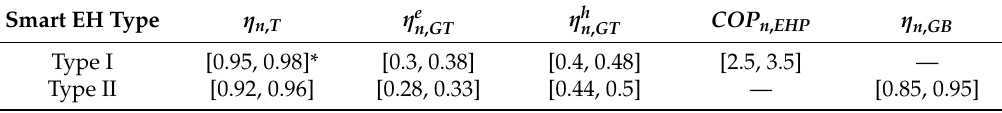
Figure 4. Mean value of energy loads of each energy hub (EH). Table 1. Parameters of smart energy hubs.